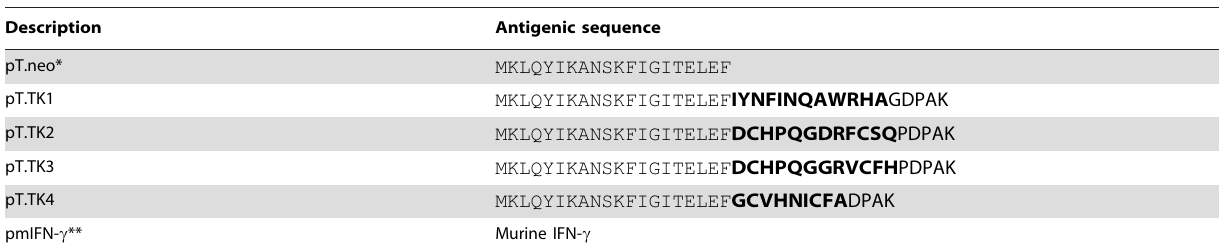
Table 2. Plasmids used for immunization studies.